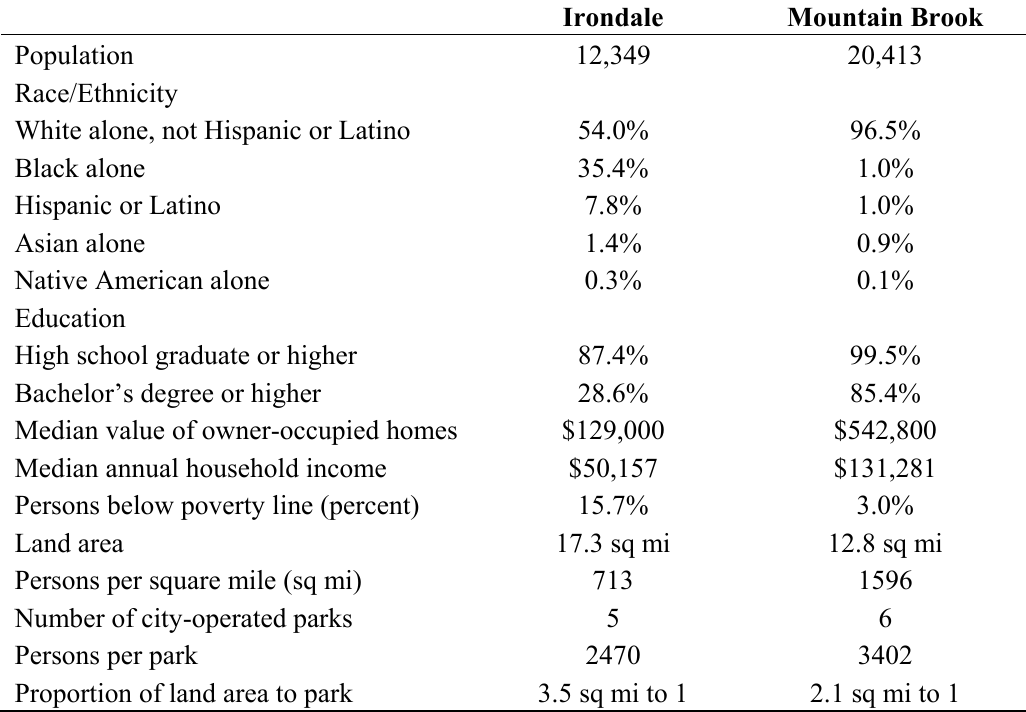
Table 1. Comparison of the characteristics of the two study cities, extracted from the United States Census Bureau data,